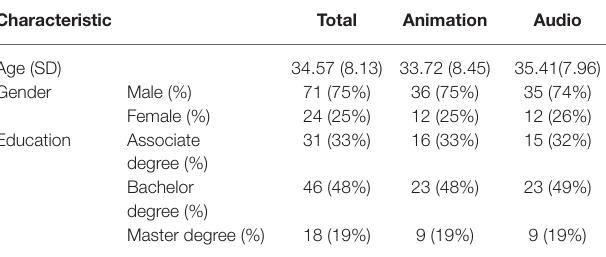
TABLE 1 | Demographic characteristics of